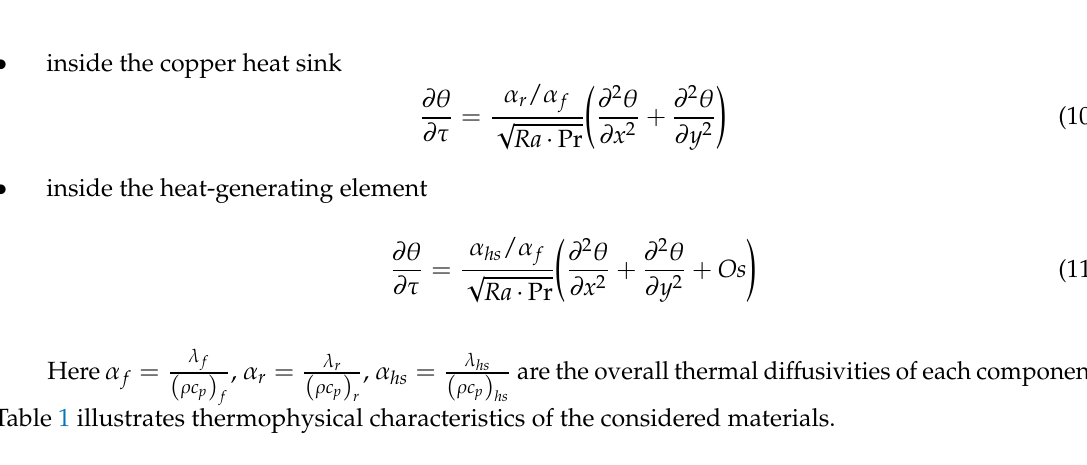
Table 1. Characteristics of